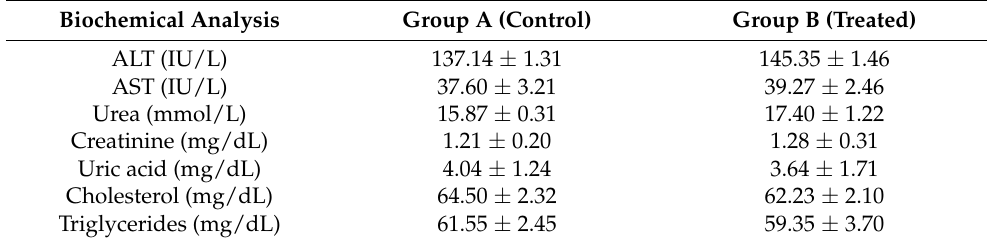
Table 5. Kidney, liver, and lipid profiles. Biochemical